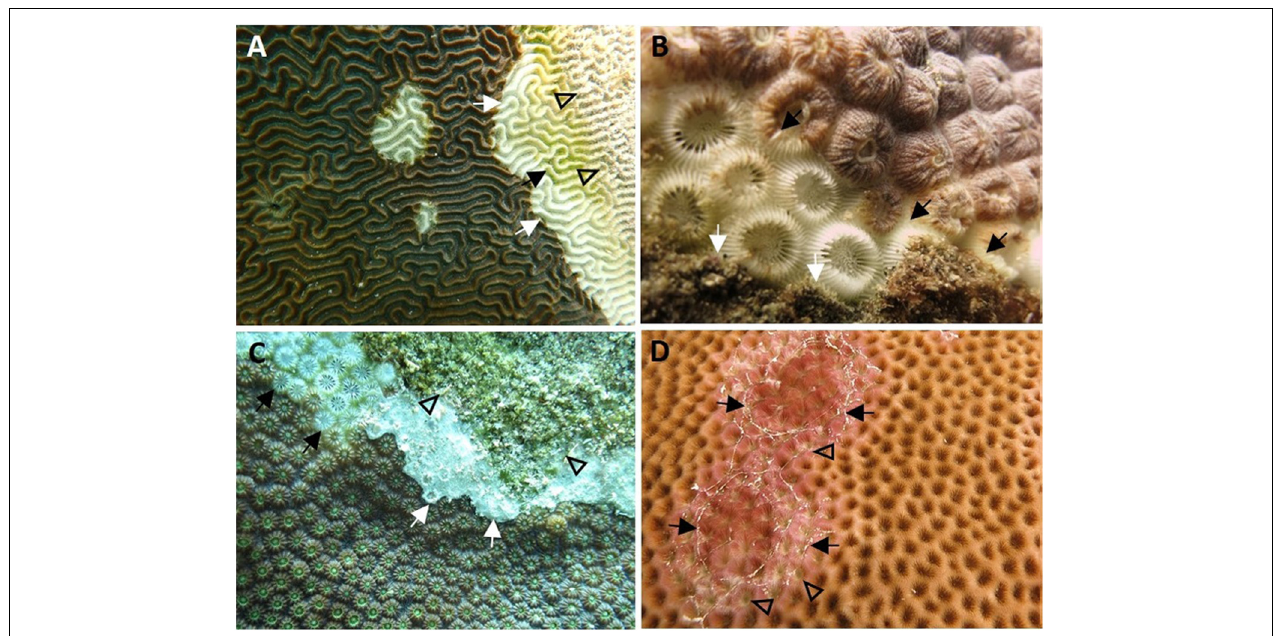
FIGURE 3 | Gross acute to chronic lesions and discoloration in stony coral tissue loss disease. (A) Pseudodiploria strigosa with multifocal acute to subacute tissue loss. Note exposed skeleton bereft of tissues partly overgrown by green turf algae (black arrow) with area further from the tissue loss margin (white arrows) covered with particulate matter (arrowheads). (B) Montastraea cavernosa with subacute to chronic tissue loss. Note distinct to indistinct band of bare white skeleton behind active disease margin (black arrows) and followed by turf overgrowth (white arrows). (C) Orbicella faveolata with chronic tissue loss. Note area of tissue loss revealing bare white skeleton (black arrows) and what appears to be a white biofilm at the tissue-loss interface (white arrows), both followed by turf overgrowth (arrowheads). (D) Siderastrea siderea with multifocal to diffuse subacute to chronic tissue loss and pinkish discoloration, with outer edges of chronic lesions covered with mucus strands (arrows). Note tissue-loss areas (arrowheads) radiating from the polyps’ oral regions and surrounding septa between adjacent polyps. (A) Near Shore Patch, April 2018; (B,C) Broward County, November 2016; (D) Grecian Rocks, July 2016. Photos: (A) Brian Reckenbeil; (B,D) Lindsay Huebner; (C) Vanessa